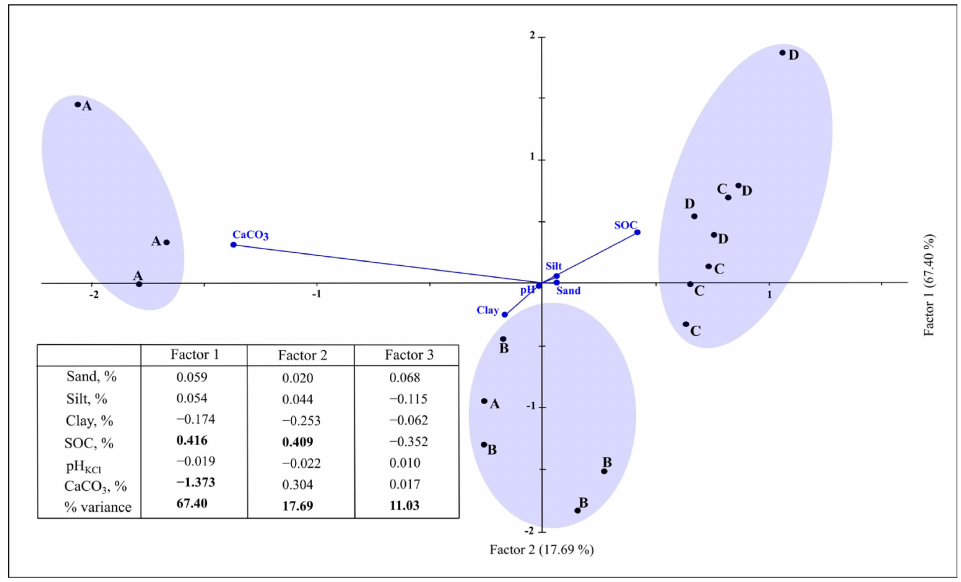
Figure 7. The main factors affecting the aggregate stability of the plow horizons: A—Soils A; B—Soils B; C—Soils C; D—Soils